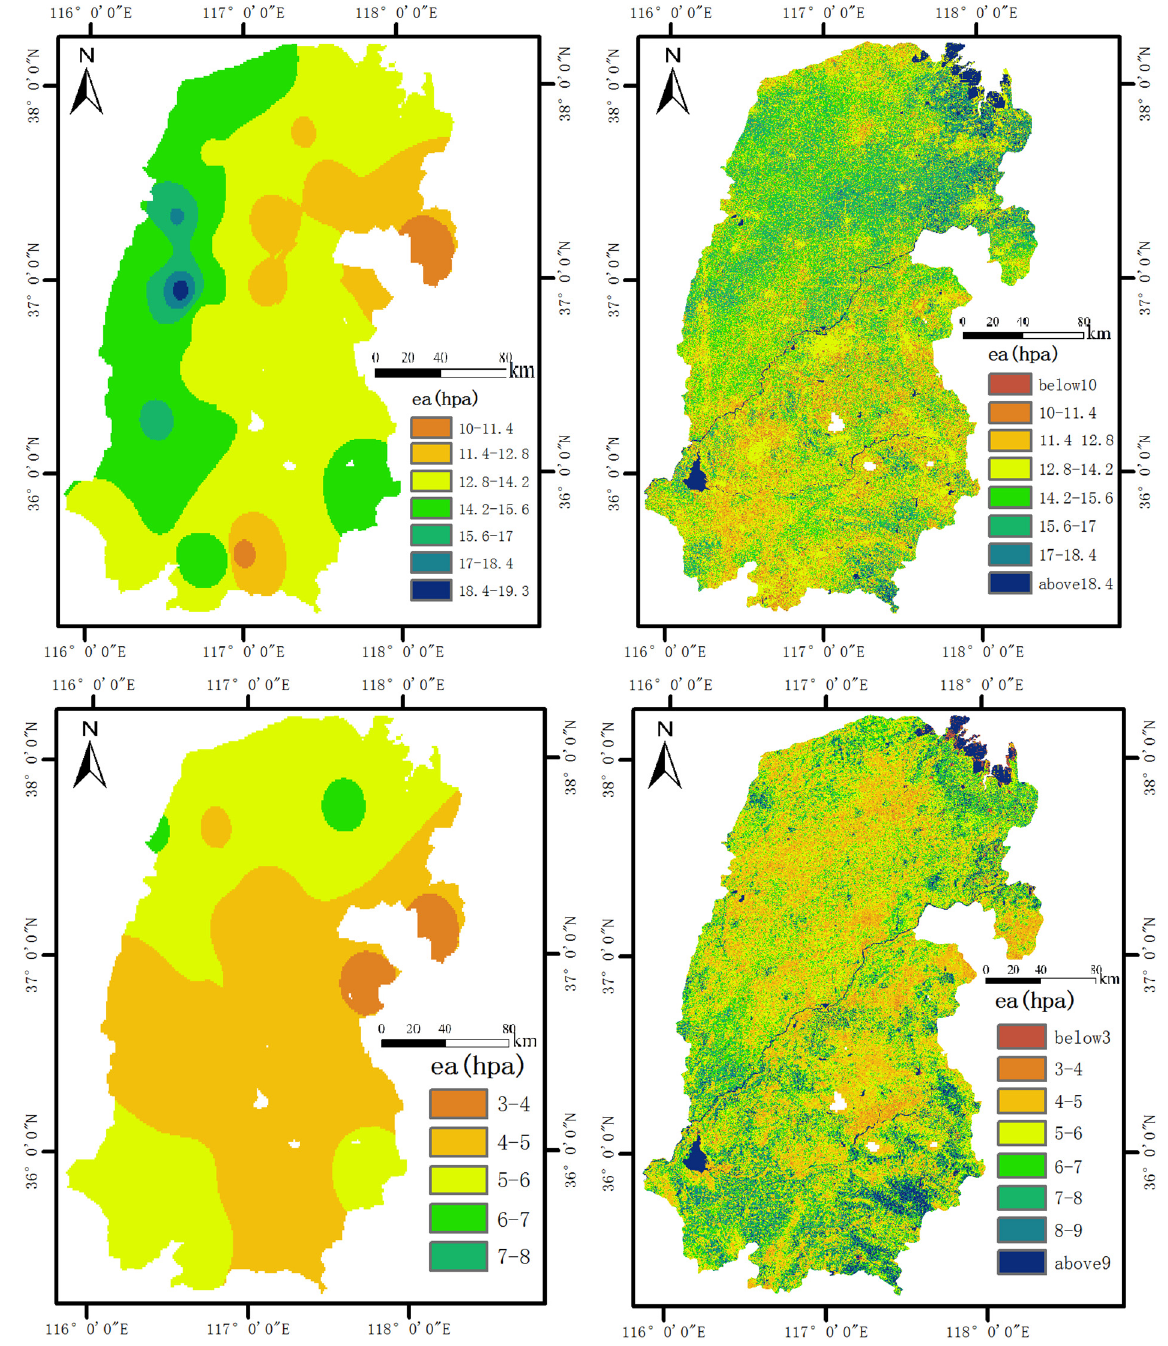
Figure 5. Spatial distributions of e a estimates from the IDW method ( left ) and the ADEBAV method ( right ) on 8April, 30 August and 17 October in